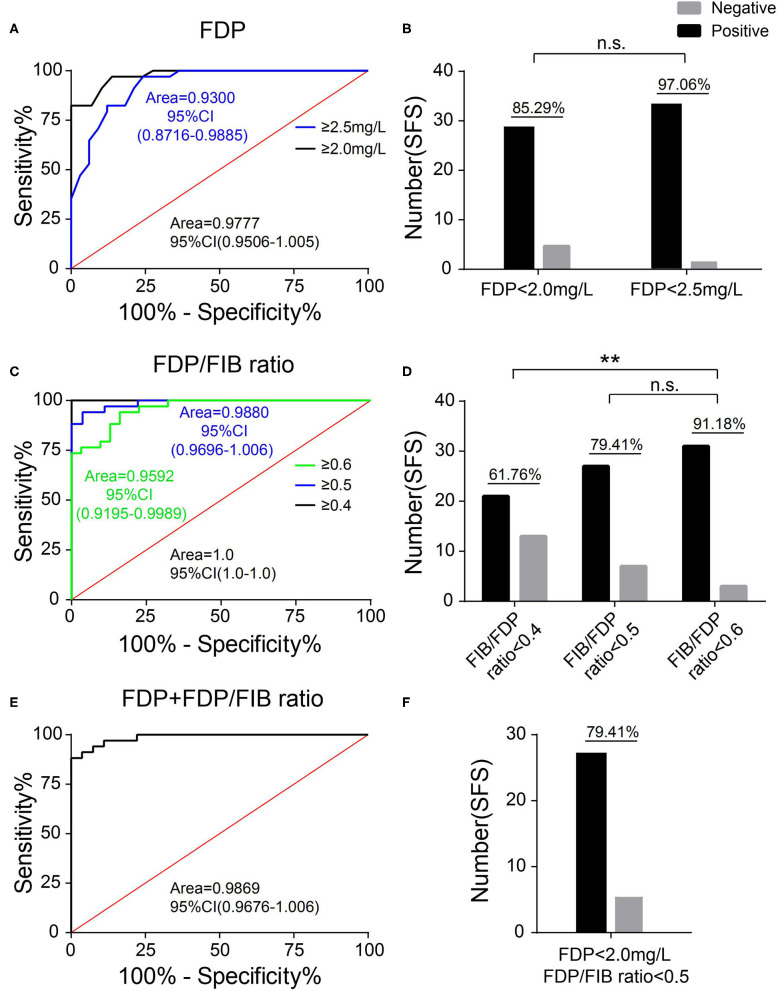
Selection of the diagnostic cutoff point. (A) The ROC curves of FDP ≥ 2.0 mg/L and FDP ≥ 2.5 mg/L as diagnostic cutoff points. (B) The proportion of patients in the SFC group with an FDP <2.0 mg/L and FDP <2.5 mg/L. (C) The ROC curves of an FDP/FIB ≥ 0.4, FDP/FIB ≥ 0.5, and FDP/FIB ≥ 0.6 as diagnostic cutoff points. (D) The proportion of patients in the SFC group with an FDP/FIB <0.4, FDP/FIB <0.5, and FDP/FIB <0.6. (E) The ROC curve of FDP ≥ 2.0 mg/L + FDP/FIB ≥ 0.5 as the combined diagnostic cutoff point. (F) The proportion of patients in the SFS group with an FDP <2.0 mg/L and FDP/FIB <0.5. n.s.: not significant; **P < 0.01.